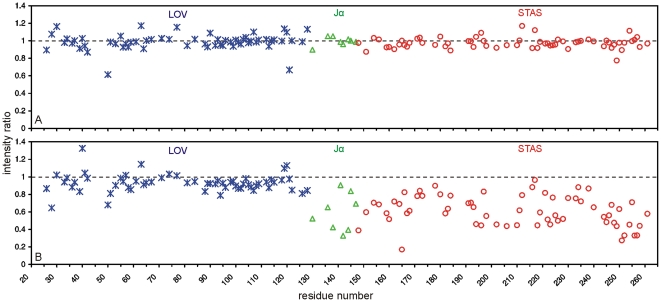
Plots of 1H-15N-TROSY cross peak intensity ratios of YtvA.Plots of the 1H-15N-TROSY cross peak intensity ratios of (A) 50 µM uniformly 2H-15N-labeled YtvA with and without 500 µM GTP and (B) 50 µM uniformly 2H-15N-labeled YtvA with and without 500 µM BODIPY-GTP against the YtvA sequence. Corresponding 2D 1H-15N-TROSY spectra were recorded with YtvA kept in the dark state. Residues are represented by asterisks for the LOV domain, triangles for the Jα-helix and circles for STAS domain. An intensity ratio of 1 (dashed line) means that the addition of the appropriate ligand has shown no effect on corresponding residues.